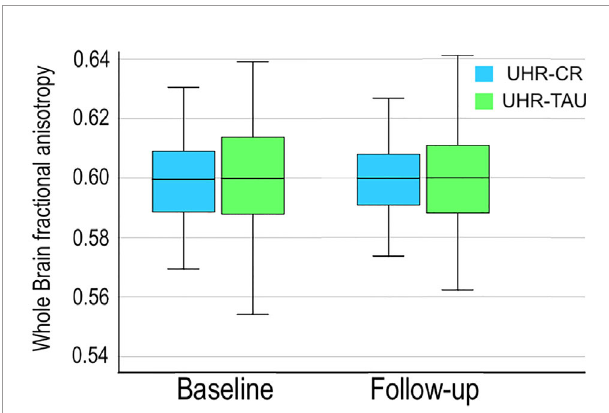
FIGURE 2 | Boxplots illustrating the development of mean whole brain fractional anisotropy at baseline and 26 weeks follow-up for UHR individuals allocated to cognitive remediation versus treatment as usual are displayed. Error bars indicate the 95% con fi dence intervals. Note that the y-axis has been altered to enhance visual display. CR, cognitive remediation; TAU, treatment as usual; UHR, ultra-high